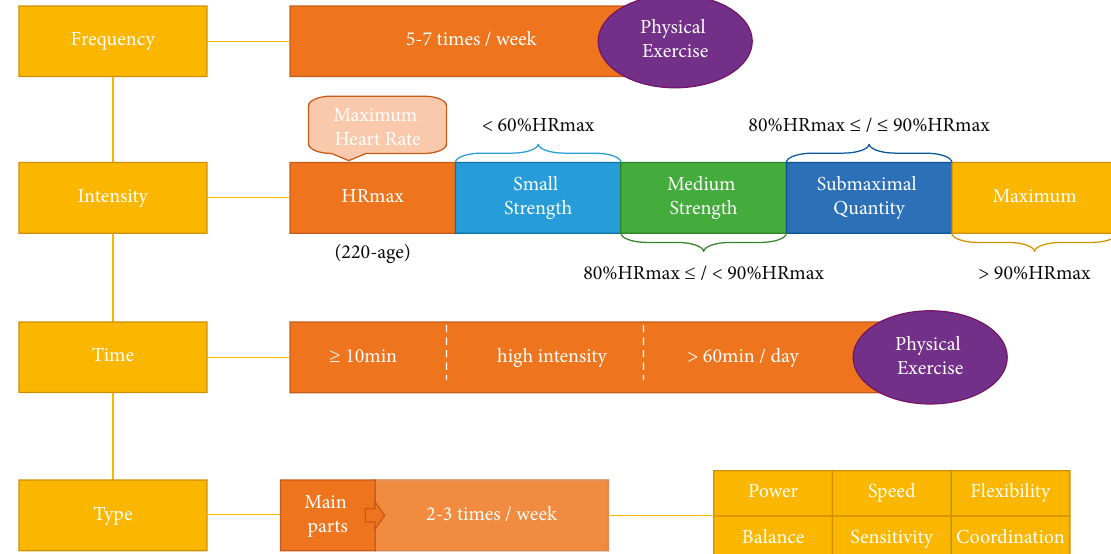
Figure 1: The relationship between aerobic exercise and obesity